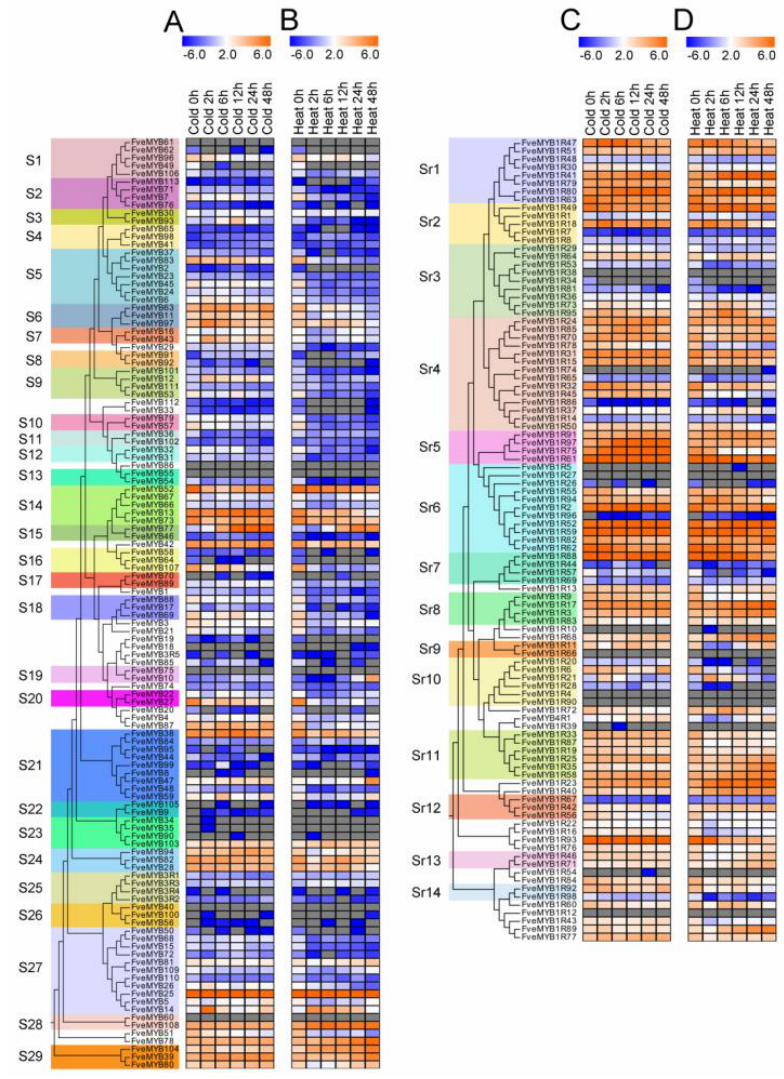
Figure 8. Expression of FveMYB genes of woodland strawberry under cold and heat stresses. ( A , C ) Expression of 2R-MYB and 3R-MYB, 1R-MYB, and 4R-MYB genes of woodland strawberry under cold stress (4 °C). ( B , D ) Expression of 2R-MYB and 3R-MYB, 1R-MYB and 4R-MYB genes of woodland strawberry under heat stress (40 °C ). Woodland strawberry variety “Hawaii 4” seedlings were used for cold and heat treatments. FPKM values were in Supplementary Table S5, and the heat map showed log2 level.